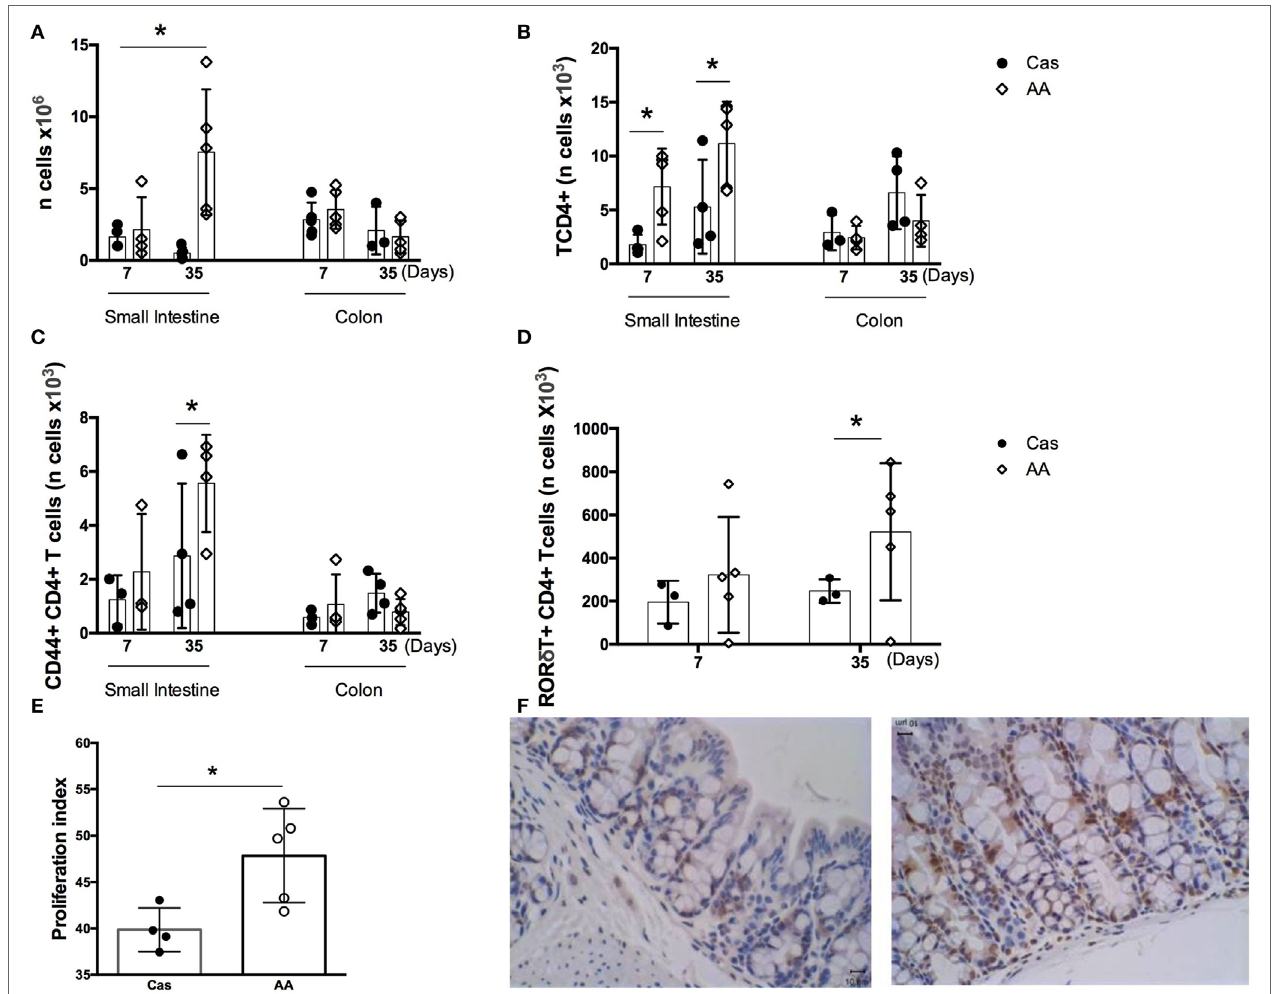
FigUre 3 | Number of cells in the lamina propria of small intestine and colon. C57BL/6 mice at 7–8 weeks of age were fed either experimental diet [diet containing free amino acids (AA diet)] or control diet [casein-containing diet (CAS diet)] for 7 and 35 days. Numbers of total cells (a) were determined by cell counting. Numbers of CD4 + T cells (b) , CD4 + CD44 + activated T cells (c) , and CD4 + ROR γ t + T cells in the small intestine (D) were determined in the lamina propria by flow cytometry analysis ( n = 4). Cell proliferation in the small intestine (e,F) was evaluated by immunohistochemistry after 7 days of diet consumption. Statistical analysis was performed between CAS-fed and AA-fed group at the end of each experimental time point using Mann Whitney test for non-parametric data. p <